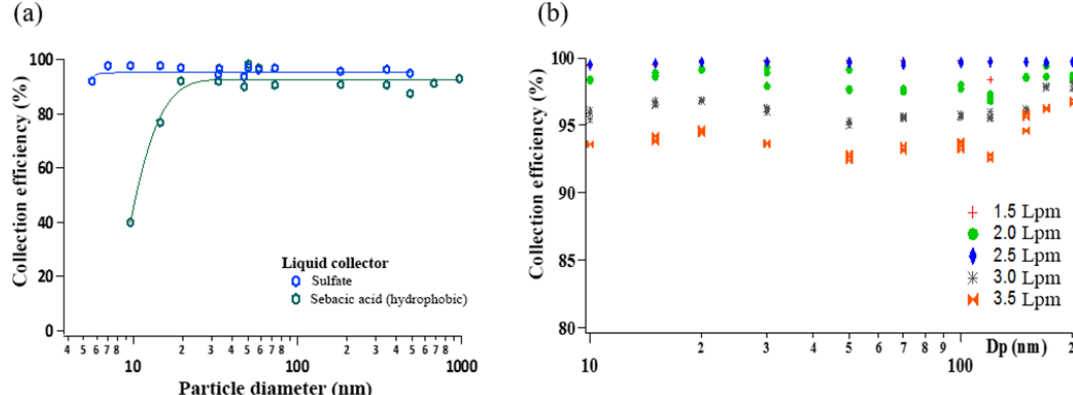
Figure 2. Collection efficiency for laboratory-generated salt and sebacic acid aerosols with the Liquid Spot Sampler: (a) with particle size and (b) with sampling flow rate for